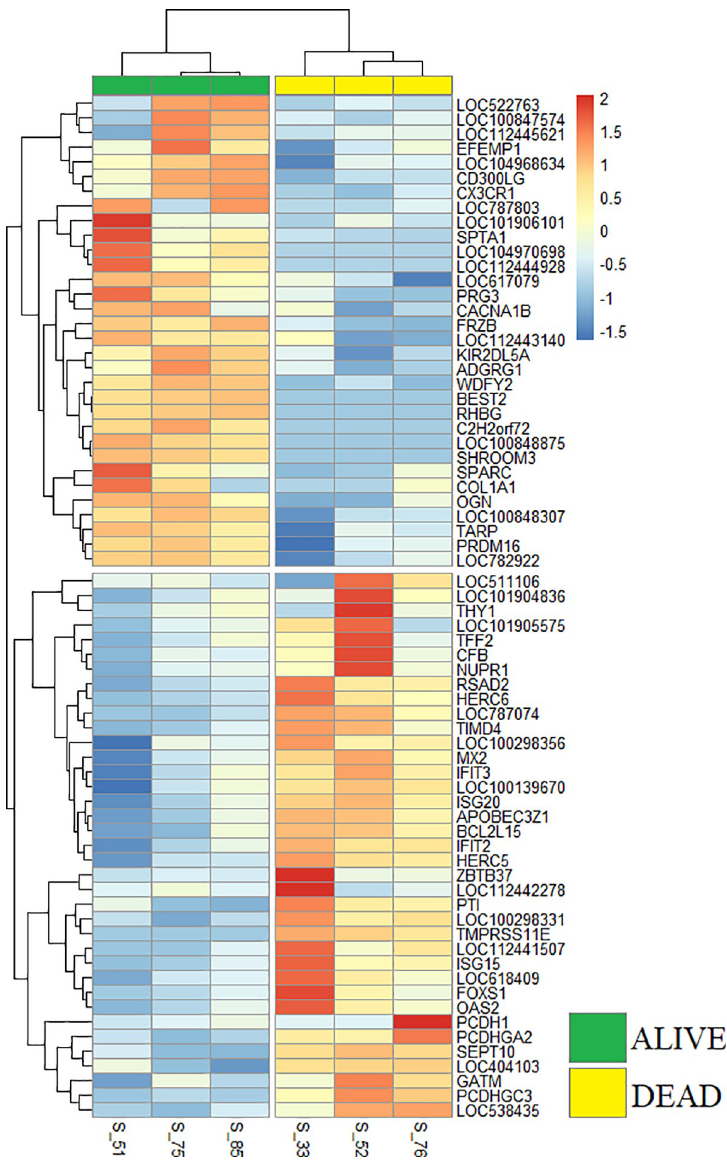
Fig 2. Hierarchical clustering of gene expression from arrival blood separates ALIVE and DEAD